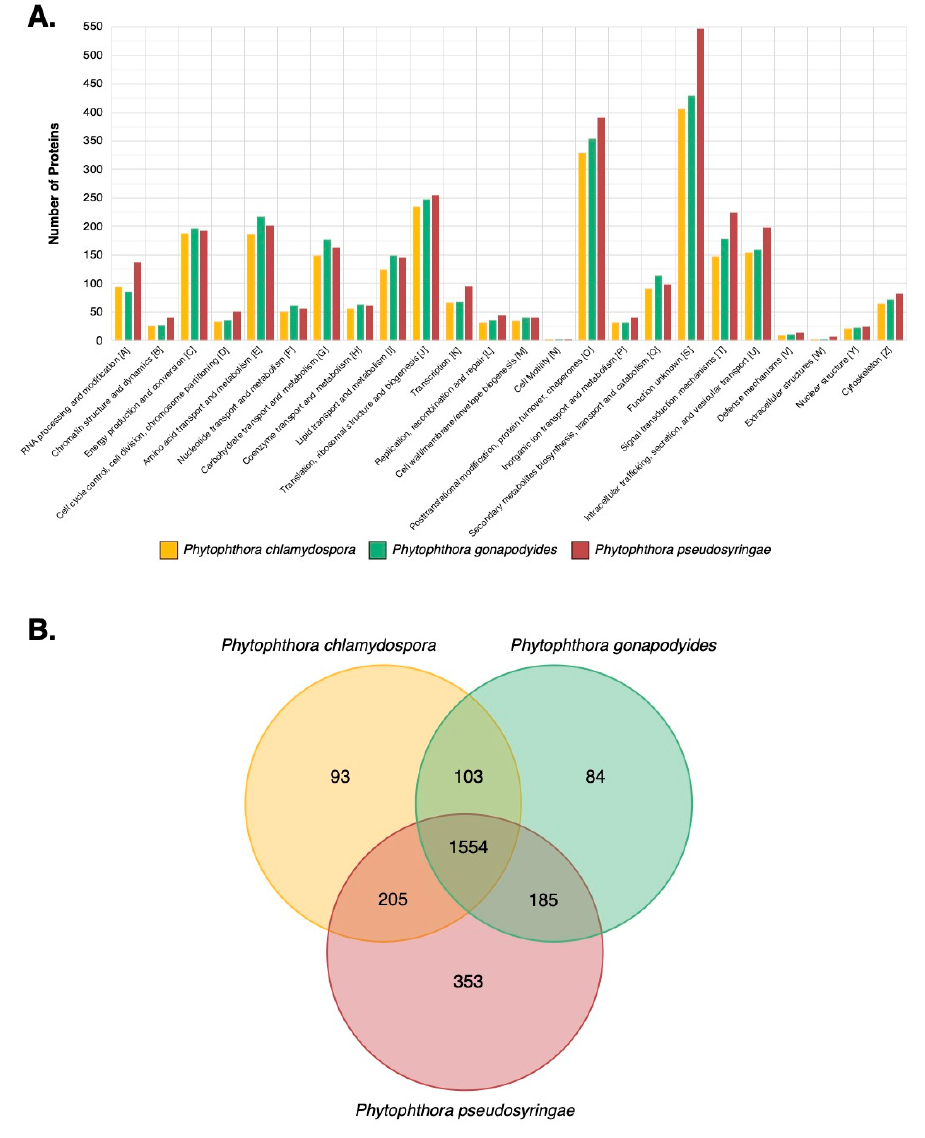
Figure 7. Functional annotation of identified mycelial proteins. ( A ) Identified mycelial proteins were functionally annotated using eggNOG-Mapper. ( B ) Venn diagram showing the number of identified mycelial protein families shared between each species.